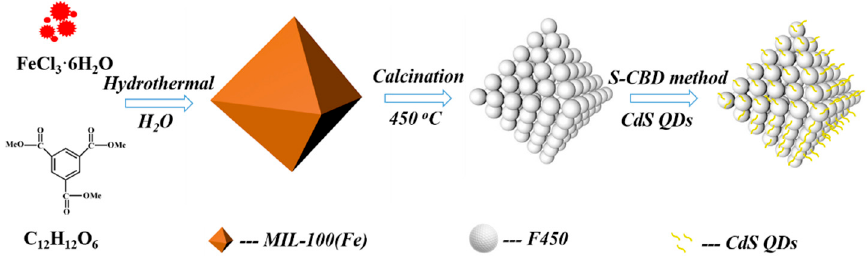
Scheme 1. Schematic flowchart for preparing of uniform samples of X–CdS/F450.